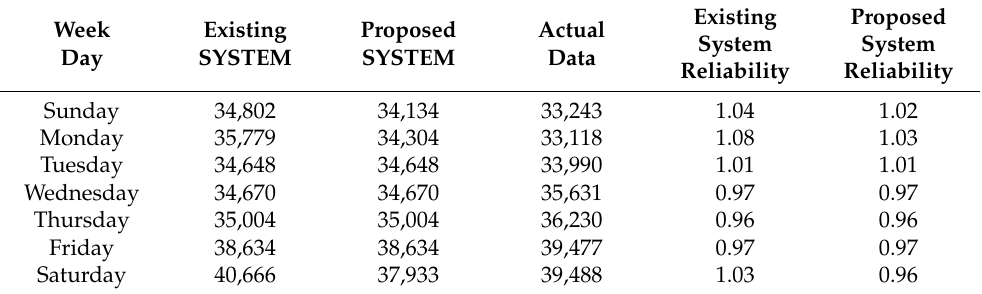
Table 3. Reliability comparison between the existing system and the proposed system for actual data.